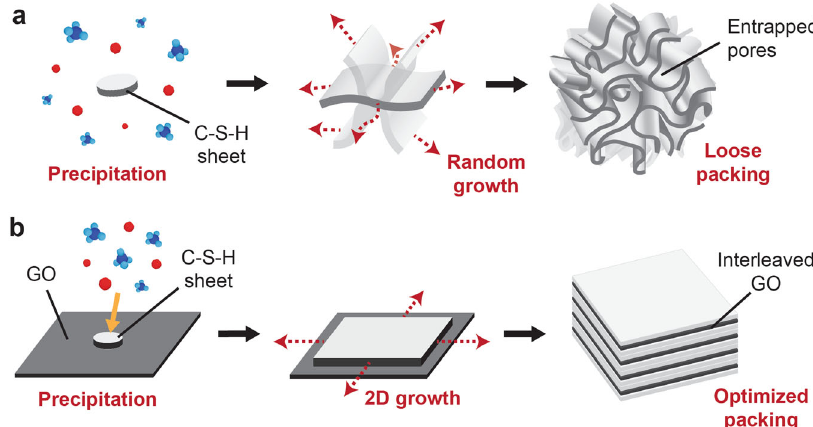
Fig. 1 Approach to controlling the nucleation, growth and packing of C – S – H sheets. a Schematic showing the nucleation, growth and loose packing of C – S – H sheets without control. b Schematic showing the approach for controlling the nucleation and growth of C – S – H sheets with GO and thereby optimising their nanoscale